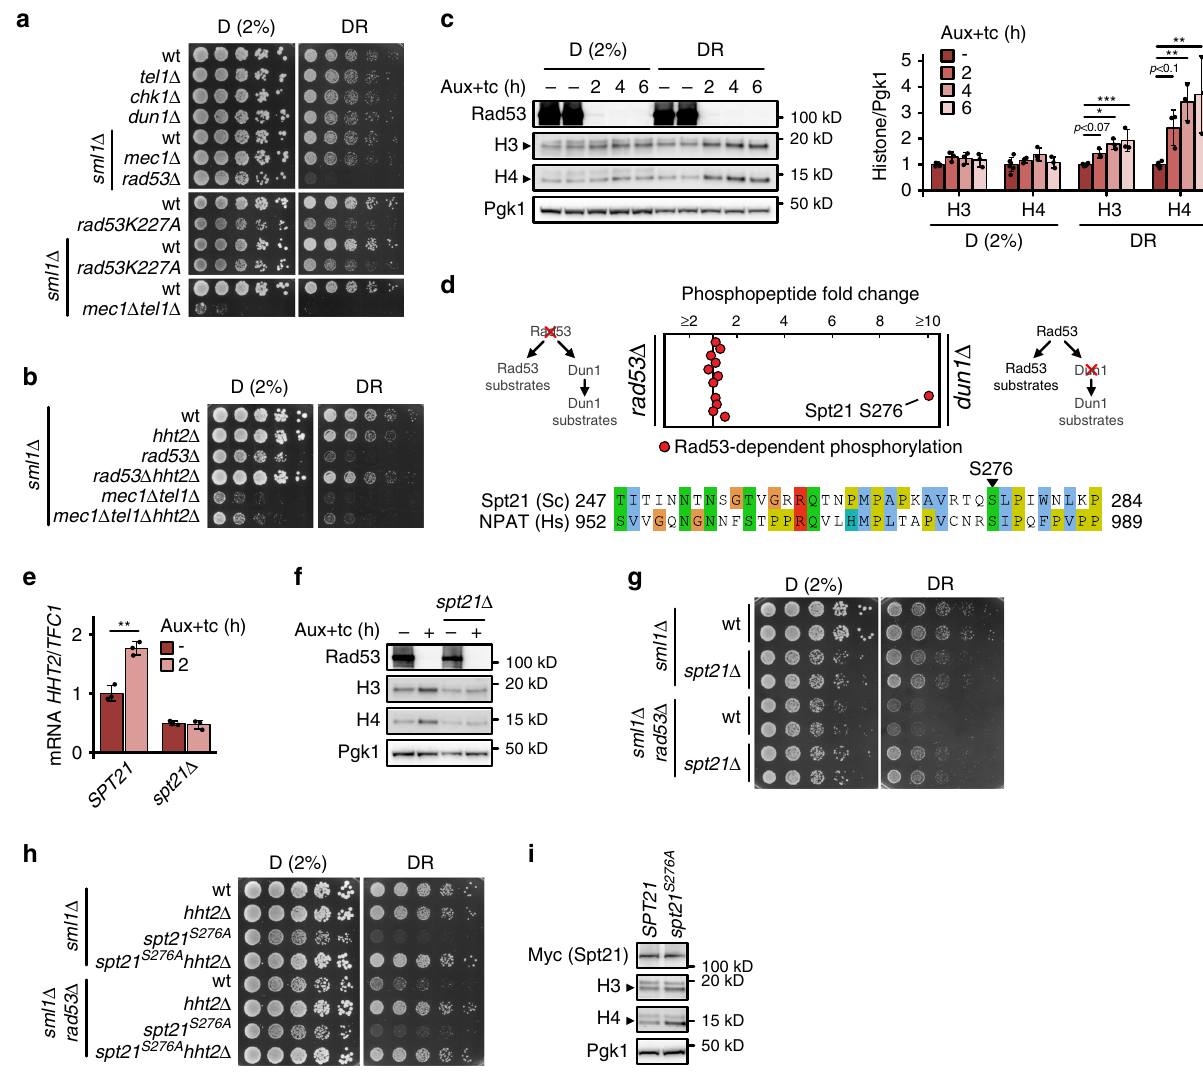
Fig. 1 A Rad53-Spt21 axis mediates tolerance to glucose restriction. a , b 10 7 cells/mL were serially diluted (1:6), spotted on YP plates with the indicated carbon sources and grown for 2d. c Rad53-AID cells were adapted to normal or low glucose, Rad53 was depleted with Auxin and tetracycline, and samples were collected at the indicated times for western blot analysis ( n = 3 independent experiments). The bar chart (right panel) provides a quanti fi cation of histone levels normalized by Pgk1. Signi fi cances were calculated with one-way ANOVA ( p DR_H3 = 0.00027, p DR_H4 = 0.0011) with post hoc Tukey HSD test ( p DR_H3_2h_vs_UT = 0.066, p DR_H3_4h_vs_UT = 0.0015, p DR_H3_6h_vs_UT = 0.00042, p DR_H4_2h_vs_UT = 0.094, p DR_H4_2h_vs_UT = 0.0044, p DR_H4_2h_vs_UT = 0.0019). d Top: quantitative mass spectrometry analysis of Dun1-dependent ( rad53 Δ ) and Rad53-dependent ( dun1 Δ ) phosphorylation events in low glucose. Each dot corresponds to a phosphorylation event previously found to exhibit Rad53 dependency (see Methods). The horizontal position represents the relative fold-change. ( n = 2 independent label swap experiments). Bottom: alignment of budding yeast Spt21 and human NPAT around Spt21-S276. e , f Rad53-AID cells with the indicated SPT21 genotype were adapted to low glucose and Rad53 was depleted with Auxin and tetracycline for 2h e or 4h f . Samples were collected to quantify histone mRNAs by RT-qPCR e or proteins by western blot analysis f ( n = 3 independent replicate cultures in e , representative blot in f ). Signi fi cance in e was calculated by Student ’ s t test (two-sided, unpaired, p SPT21 _2h_vs_UT = 0.0017). g , h 10 7 cells/mL were serially diluted (1:6), spotted on YP plates with the indicated carbon sources and grown for 2d. i Spt21-AID and Spt21 S276A -AID cells were adapted to low glucose and Auxin for 16 h. Auxin was washed away to stabilize Spt21 and samples were collected after 6 h to quantify proteins by western blot analysis. Bars plots with error bars represent mean values and standard deviation, D glucose; DR glucose restriction (0.01% a , b , g or 0.04% h in solid media, 0.02% in liquid media), Aux Auxin; tc tetracycline. * p < 0.05, ** p < 0.01, *** p <